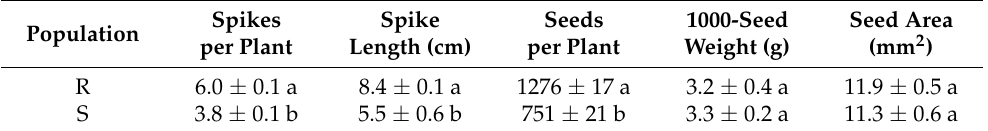
Table 3. Number of spikes, spike length, number of seeds, 1000-seeds weight, and seed area of resistant (R) and susceptible (S) P. brachystachys sub-populations to the ACCase-inhibiting herbicides. Spikes Spike Seeds Population per Plant Length (cm) per